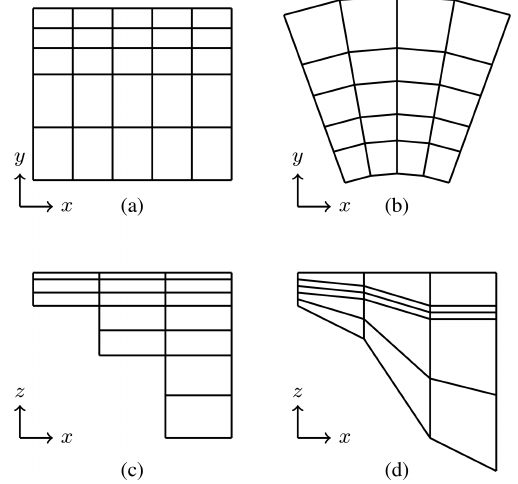
Figure 1. Grid discretizations processed by Parcels. In the horizon- tal plane: (a) rectilinear, (b) curvilinear; in the vertical: (c) z levels and (d) s levels. Four combinations of horizontal and vertical grids are possible to form a three-dimensional mesh.